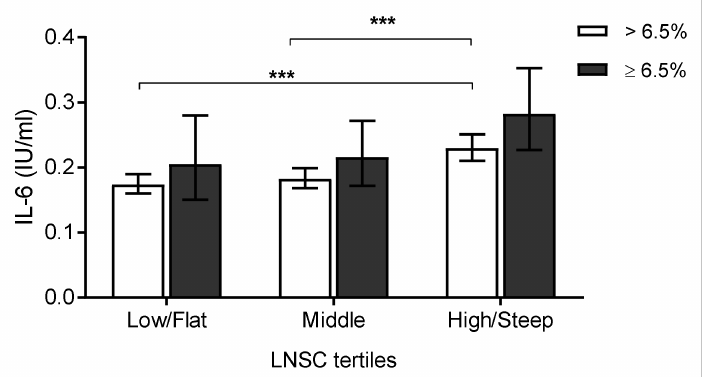
Figure A4. Age- and sex-adjusted LSmeans of Interleukin-6 (IL-6) (pg/mL) concentration by tertiles of LNSC according to glycemia status using the HbA1c cut-off of 6.5% ( n = 758).